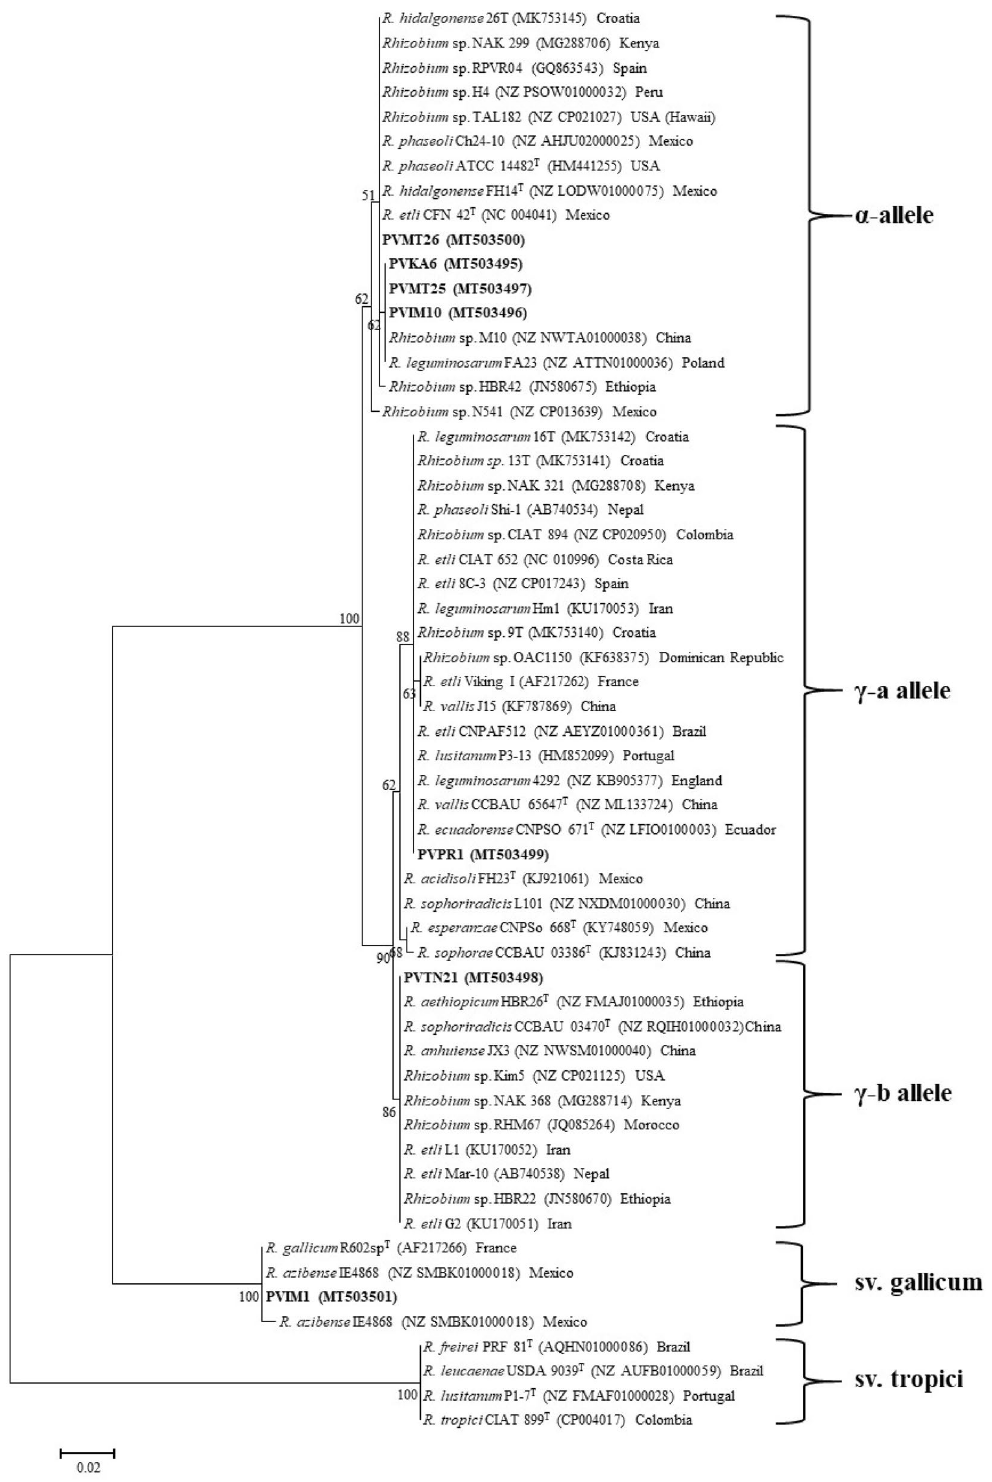
Figure 5. Maximum likelihood phylogenetic tree based on nodC gene sequences (405 bp) showing phylogenetic relationships between the strains of the symbiovars phaseoli and gallicum isolated in this work and those in other geographical locations. Strains isolated in the present study are shown in boldface and type strains are indicated by superscript “T”. GenBank accession numbers of the sequences are indicated within parentheses. Bootstrap values (greater than 50%) were calculated for 1000 replications and are shown at the nodes. The scale bar shows the number of nucleotide substitutions per site. Phylogenetic analysis was conducted in MEGA 6 104 (https:// www. megas oftwa re. net/) using the maximum likelihood algorithm with the Tamura 3-parameter model (T92). R., Rhizobium